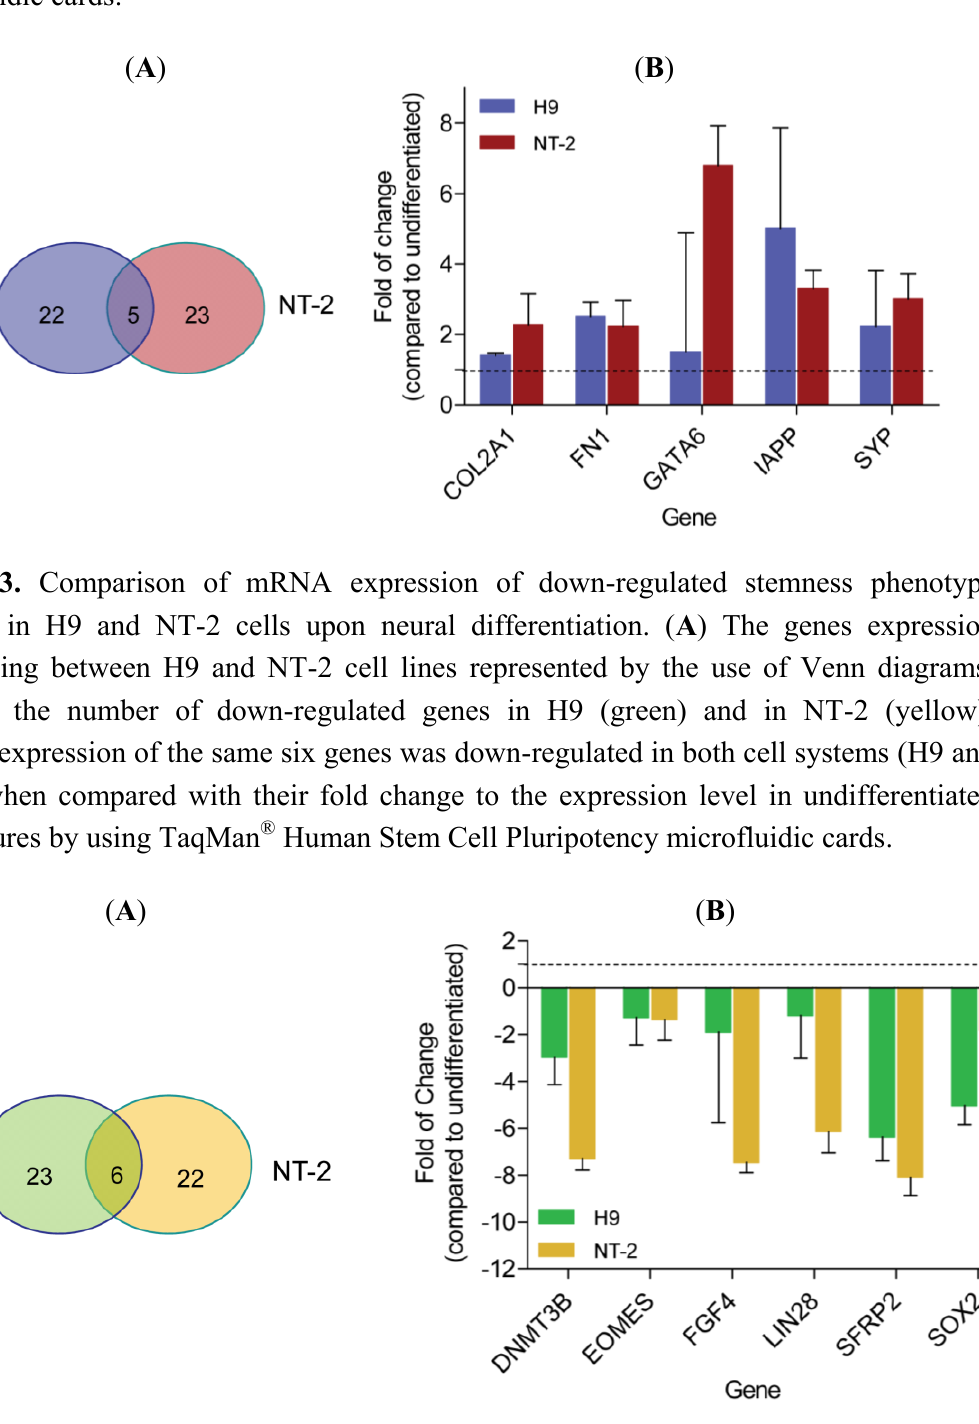
Figure 2. Comparison of mRNA expression of up-regulated stemness phenotype markers in H9 and NT-2 cells upon neural differentiation. ( A ) The comparison between the number of up-regulated genes in H9 at 10 DIV (blue) and in NT-2 at 36 DIV (red) cell line (compared to undifferentiated cells) illustrated by the use of Venn diagrams. Among the upregulated genes five of them ( COL2A1 , FN1 , GATA6 , IAPP , and SYP ) were overlapping being over-expressed in both cell systems; ( B ) The fold change of the gene expression of the five up-regulated genes overlapping between the differentiated H9 and NT2 cell cultures has been quantified by using TaqMan ® Human Stem Cell Pluripotency microfluidic cards.